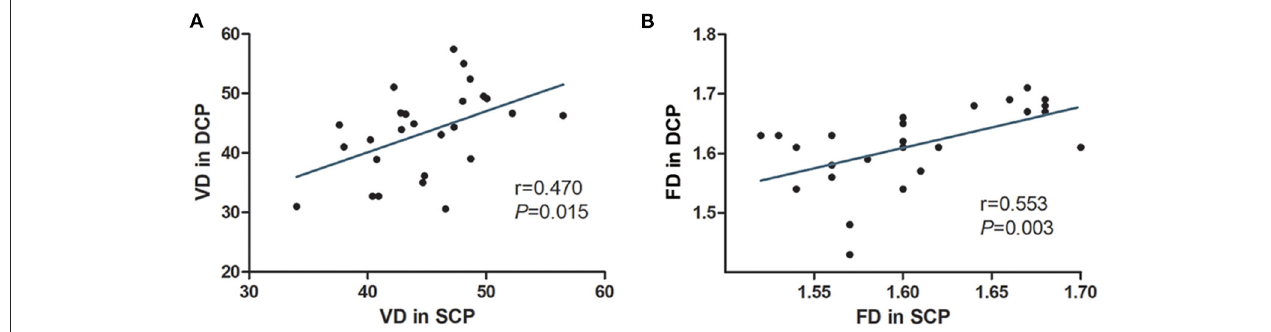
FIGURE 4 | The correlations of OCTA parameters of eyes with macular edema or exudation secondary to Coats’ disease. The parafoveal VD in the SCP of the affected eyes was linearly correlated with that in the DCP (A) . The parafoveal FD in the SCP of the affected eyes was linearly correlated with thast in the DCP (B) .